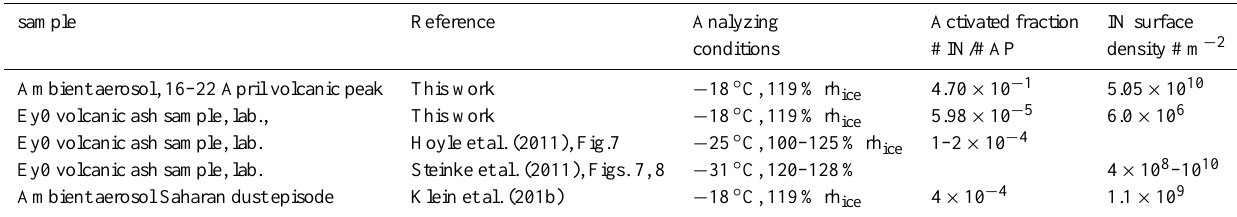
Table 1. Deposition nucleation properties of Eyjafjallaj¨okull volcanic aerosol collected from ambient air, from laboratory generated aerosol of ash sample Ey0, and of Saharan dust aerosol; AP = Aerosol particles.